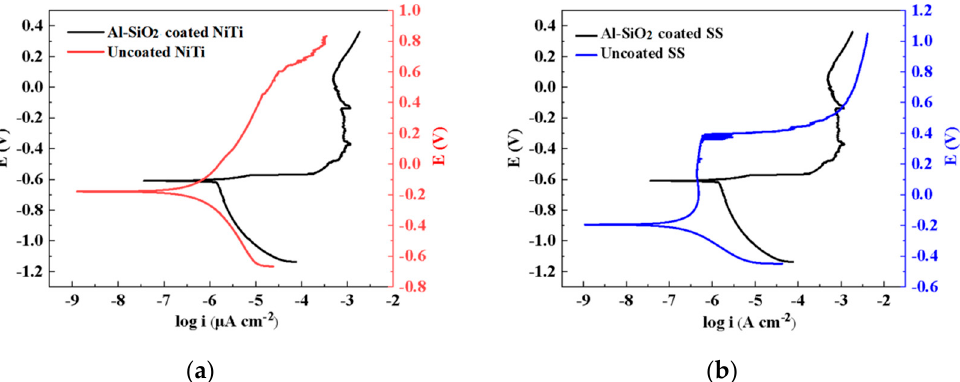
Figure 5. Electrochemical results for the coated archwires. Dynamic polarization curve of the NiTi group ( a ). Dynamic polarization curve of the SS group ( b ). Table 2. Corrosion parameters from the polarization curves.